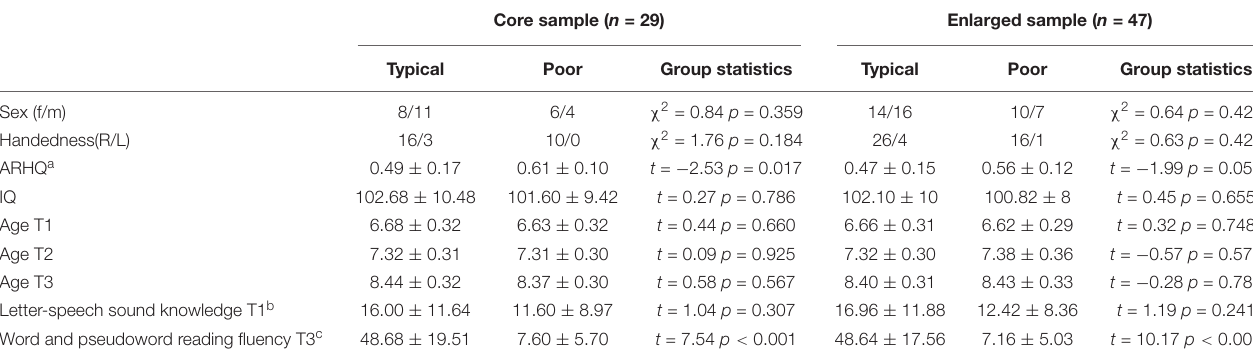
TABLE 1 | Participant characteristics.